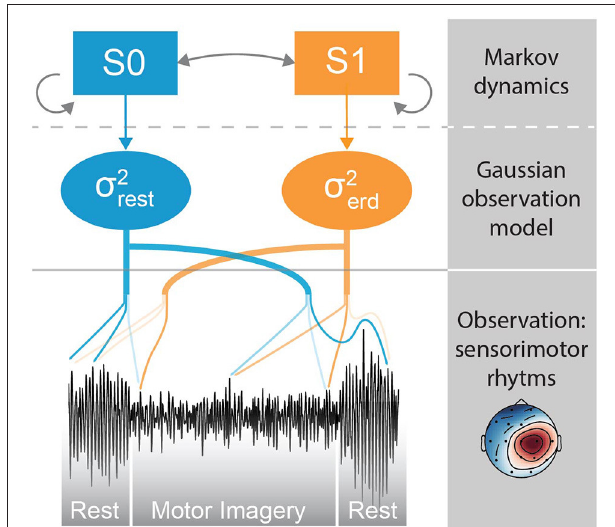
FIGURE 2 | Conceptual representation of the Markov switching model (MSM). The sensorimotor rhythms are obtained by CSP spatial filtering. The MSM is composed of a Gaussian observation model whose variance is governed by Markovian dynamics. If the variance of the sensorimotor rhythm is high, the probability of state S 0 is high; if the variance is low, the probability of S 1 is high. The probability of S 1 represents the probability of an